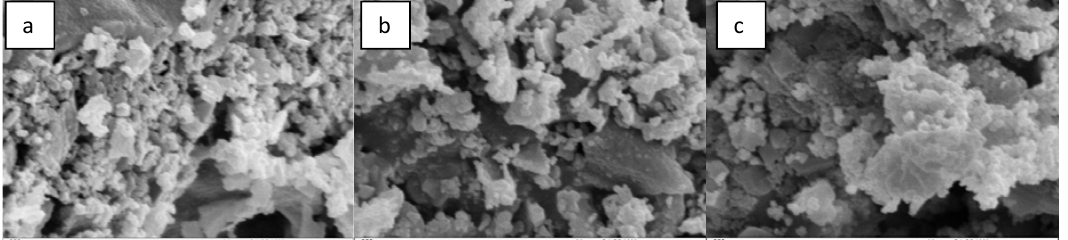
Fig. 6. SEM images of NiFe